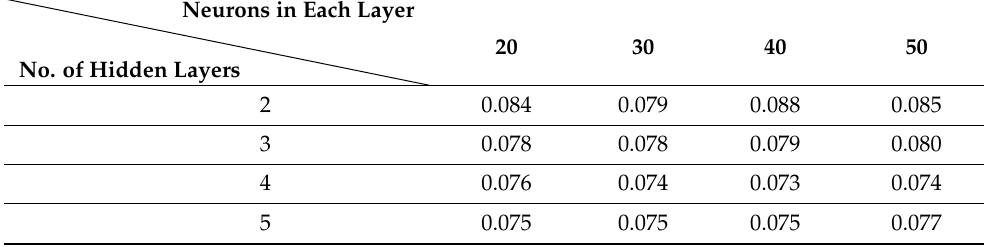
Table 2. Mean absolute error of validation data sets for neural network grid search.